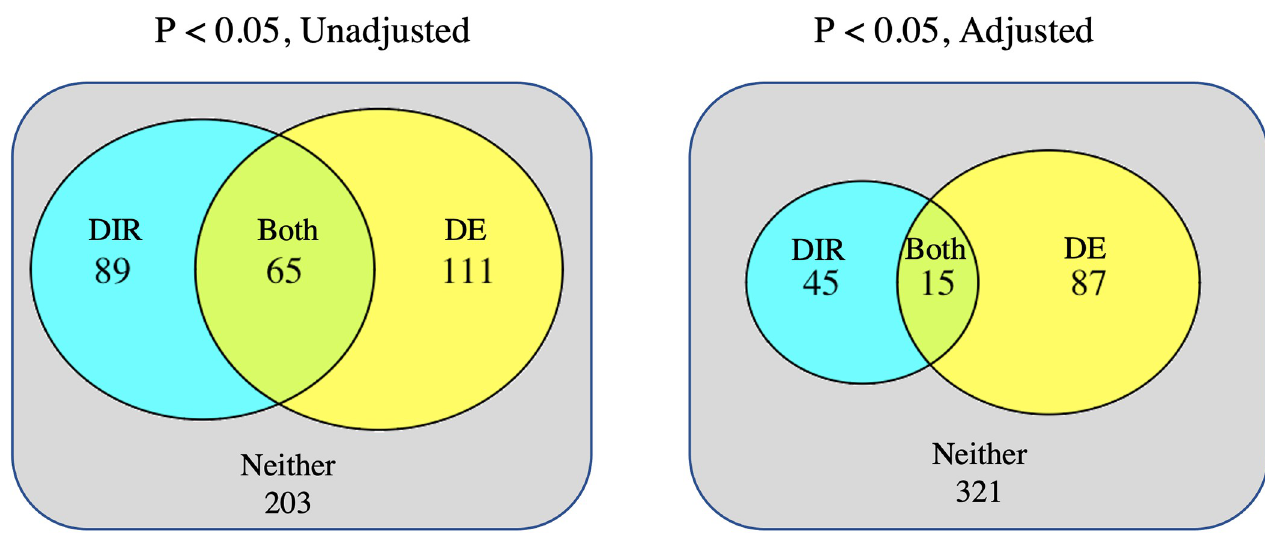
Fig 4. DE does not overlap with DIR. Significance in one does not predict significance in the other (One-sided Fisher’s exact test, p = 0.091 (left) and 0.310 (right)). Compared are results using high purity samples for DE (model ~ sample type + batch ID) and quality-controlled samples for DIR. Compared are the 468 kinase genes with > 1 coding